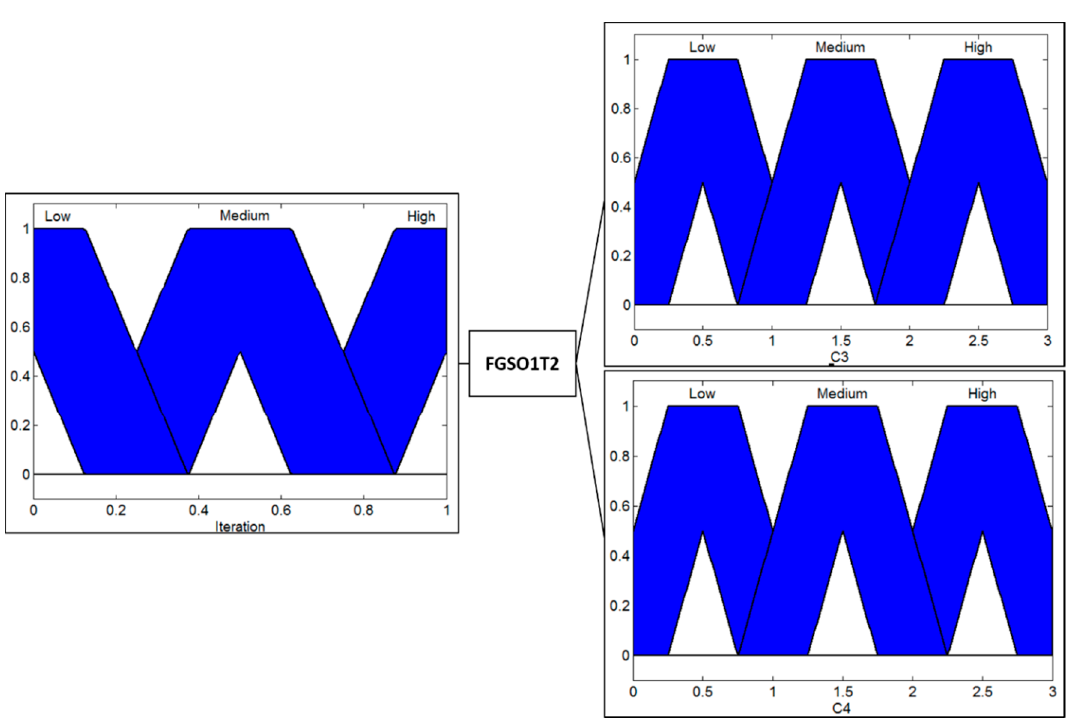
Figure 4. IT2 fuzzy system FGSO1T2.